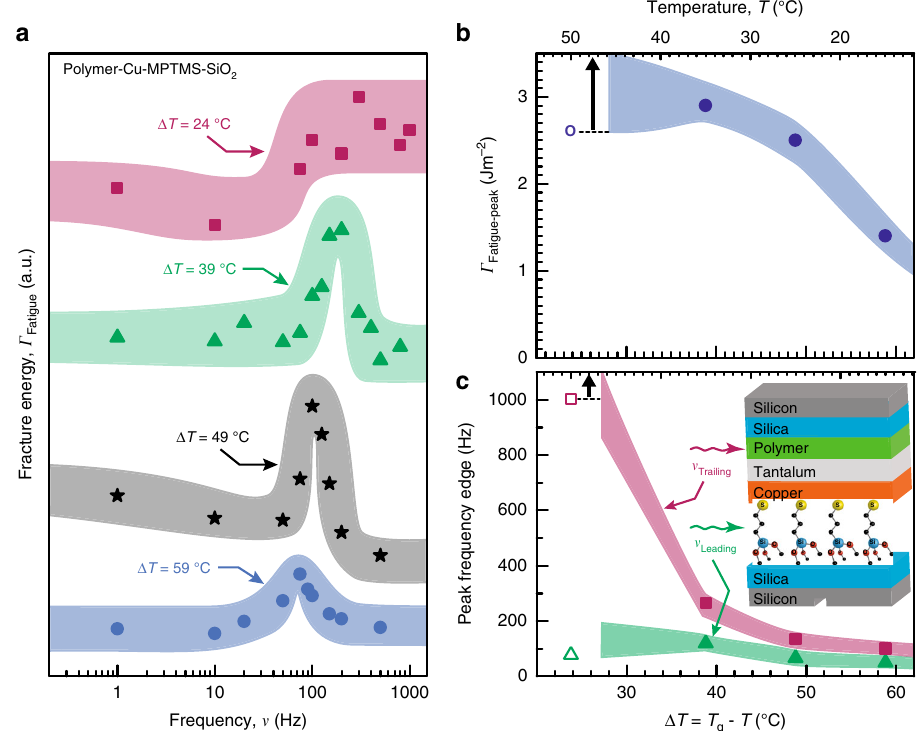
Fig. 5 Temperature-dependence of the fatigue toughening magnitude and frequency characteristics. a Fatigue fracture energy Γ Fatigue of polymer-metal- = 1.3 kPa. b The Γ ν MPTMS-silica interfaces for 24 °C ≤ Δ T ≤ 59 °C, at p Fatigue trailing edge frequency Trailing (magenta squares), leading edge H 2 O frequency ν Leading (green triangles), and c Γ Fatigue peak height Γ Fatigue-peak (blue circles), plotted as a function of Δ T . The Γ Fatigue-peak and ν Trailing values shown for Δ T = 24 °C represent the lower bounds (open symbols) because the ν Trailing edge at this temperature extends beyond our instrument frequency range. Each data point in b and c is extracted from the corresponding curve in a . The width of the bands, drawn through the data points to guide the eye, connote the experimental uncertainties measured as standard